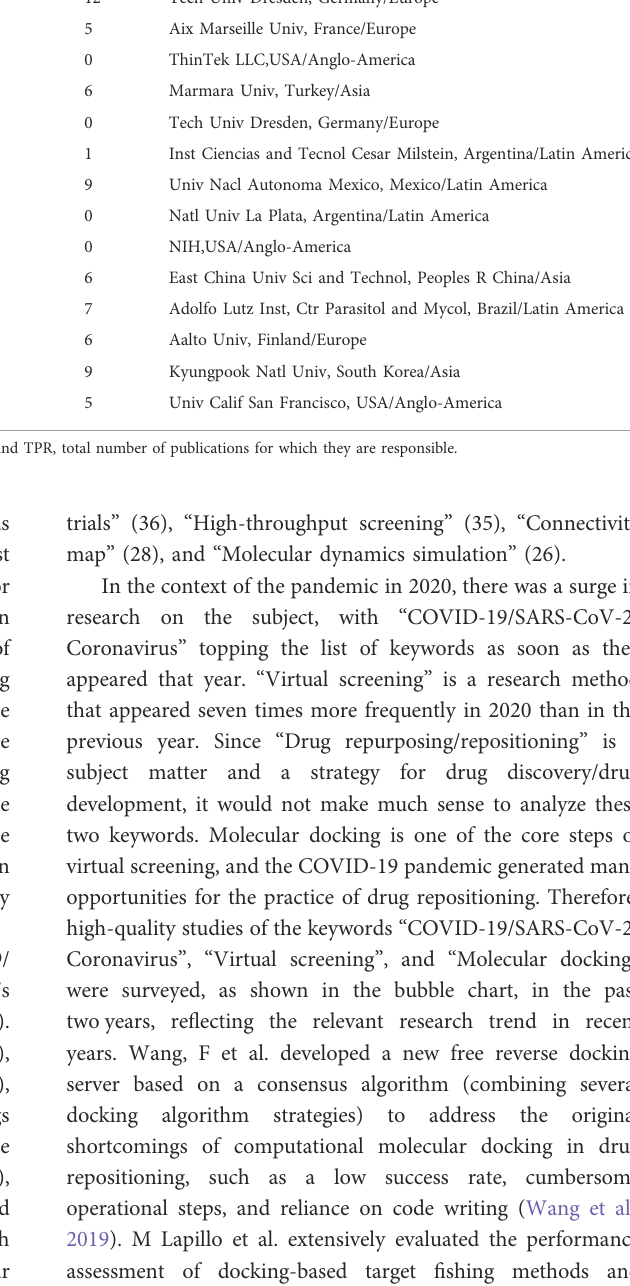
The top 30 keywords include fi ve diseases: “ COVID-19/ SARS-CoV-2/Coronavirus ” (239), “ Cancer ” (75), “ Alzheimer ’ s disease ” (48), “ Breast cancer (36)", and “ Chagas disease ” (27). Drug names appear four times, “ Antiviral drugs ” (56), “ Metformin ” (35), “ Statins ” (28), and “ Antibiotics ” (25), which reveal the diseases and applications to which drugs